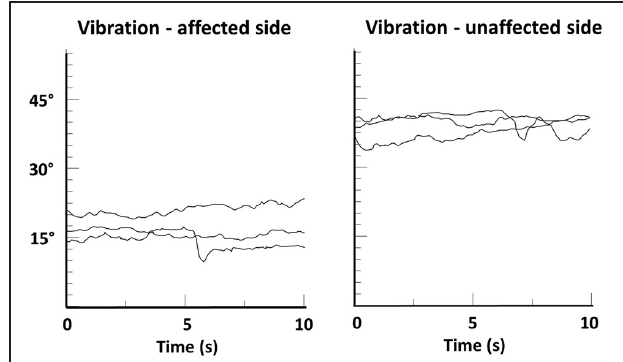
FIGURE 6 | Head position-time series data of a patient with spasmodic torticollis during muscle vibration of the left or right splenius muscle. Shown are changes in head angle in the fontal plane during three trials of vibration, each lasting 10 s. A head angle of 0 ◦ corresponds to an upright head position. Note that head angle during vibration of the unaffected side remained above 30 ◦ , while vibration of the affected side resulted in a significant righting reaction (head angle ≈ 15 ◦ ). From Karnath et al.